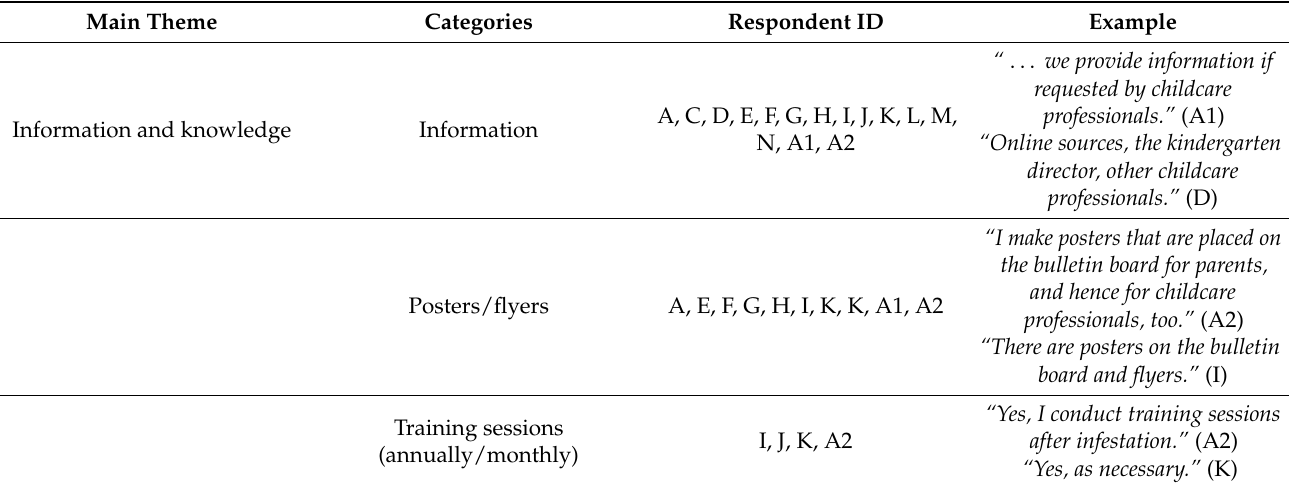
Table 4. Thematic analysis of categories and verbatim quotes for theme two: “ Information and knowledge